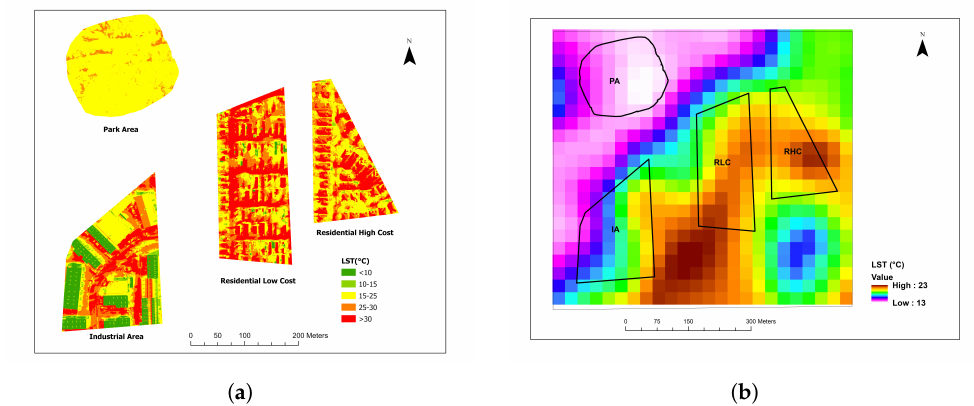
Figure 10. Spatial variation of LST from Zenmuse H20T and Landsat. ( a ) LST recorded by Zenmuse